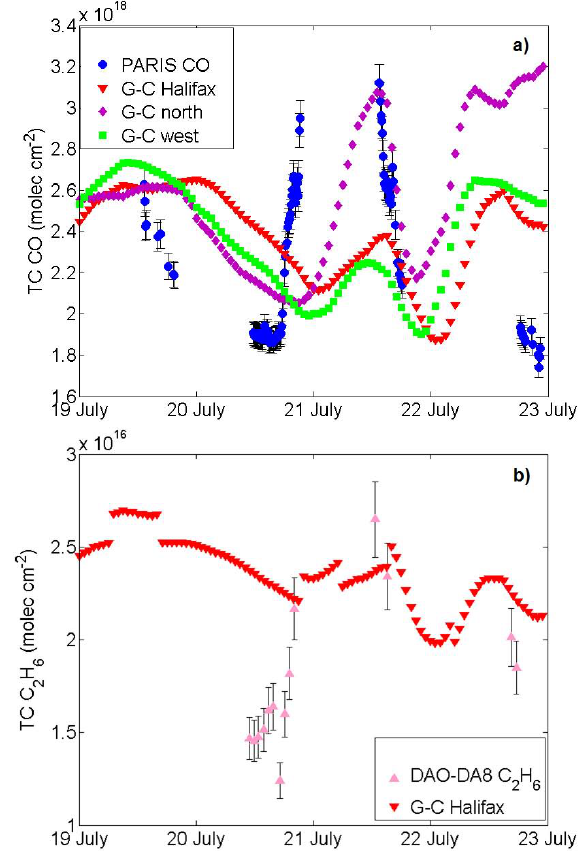
Fig. 8. Panel (a) shows the total column CO from PARIS-IR (blue circles) and GEOS-Chem for the grid box above Halifax (red in- verted triangles), north of Halifax (purple diamonds) and west of Halifax (green squares) between 19 and 22 July 2011 UTC. Panel (b) shows the total column C 2 H 6 from DAO-DA8 (pink triangles), and the C 2 H 6 total columns of the GEOS-Chem simulation (red inverted triangles) above Halifax. Note that the difference between C 2 H 6 for the three GEOS-Chem grid boxes is not significant; there- fore, only the simulation over Halifax is shown. The profiles from the GEOS-Chem simulations have been smoothed with PARIS (for CO) and DAO-DA8 (for C 2 H 6 ) averaging kernels before calculat- ing the total columns; see Sect. 2.5 for details on the smoothing pro- cedure. The black bars indicate the estimated uncertainty for each gas and ground-based instrument, as listed in Table